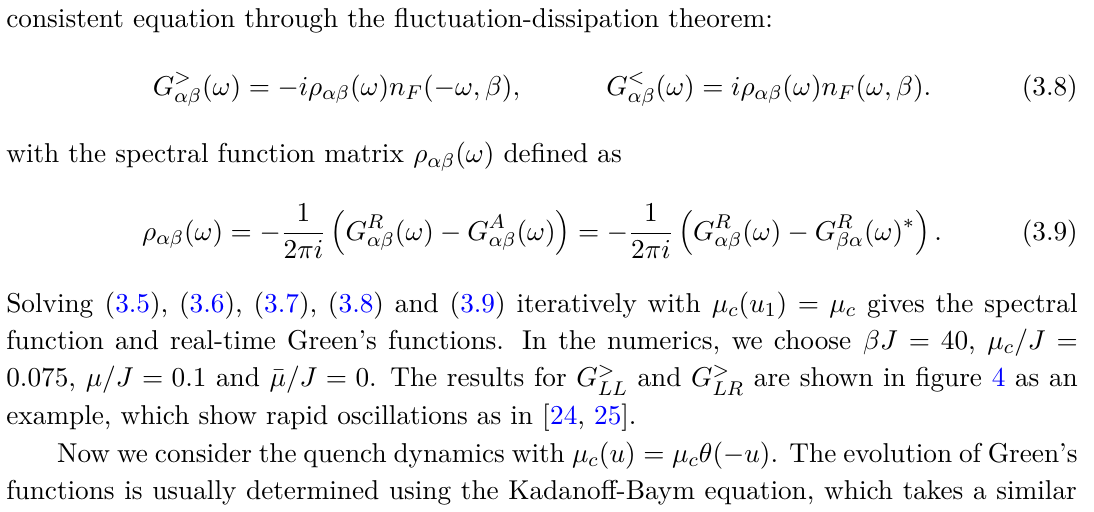
( u 1 , u 2 ) in (b). When u 1 > 0 and u 2 > 0 , we find G > LR ( u 1 , u 2 ) only depends on u 1 + u 2 . We also plot G > LR